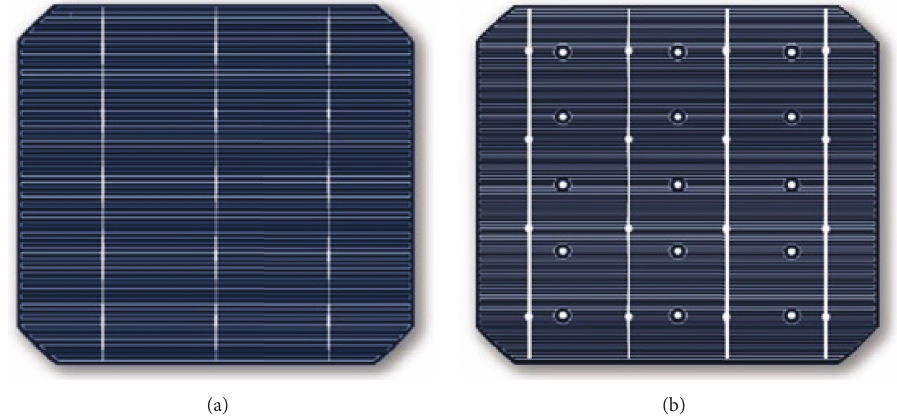
Figure 5: Image of n-type MWT silicon solar cells with a H-pattern-based unit cell design. Front side (a) and rear side (b) [38].